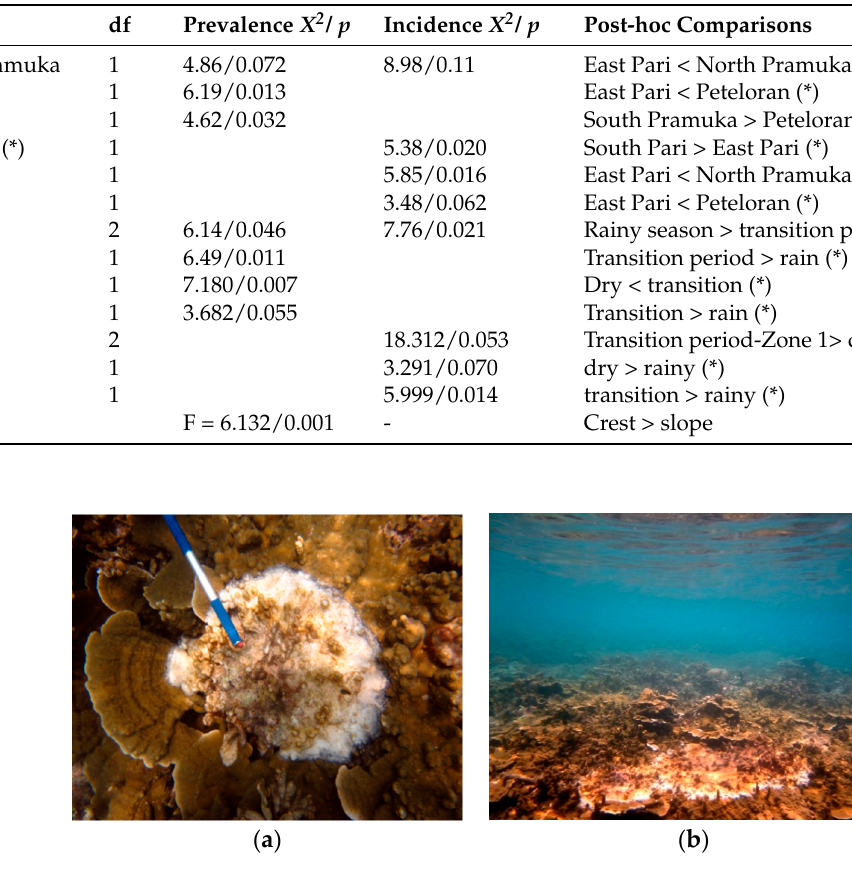
Figure 2. ( a ) Representative image of Montipora sp. showing signs of BBD, which often started in the centre of the colonies; ( b ) the majority of colonies showing signs of BBD were found in shallow waters (less than 2 m depth).